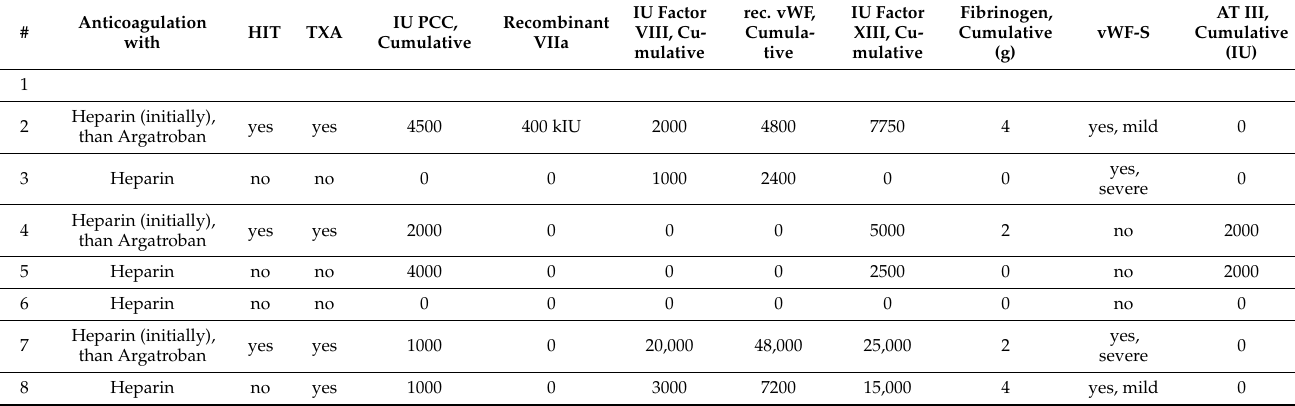
Table 4. Anticoagulation, the occurrence of HIT, cumulative dose of coagulation factors.